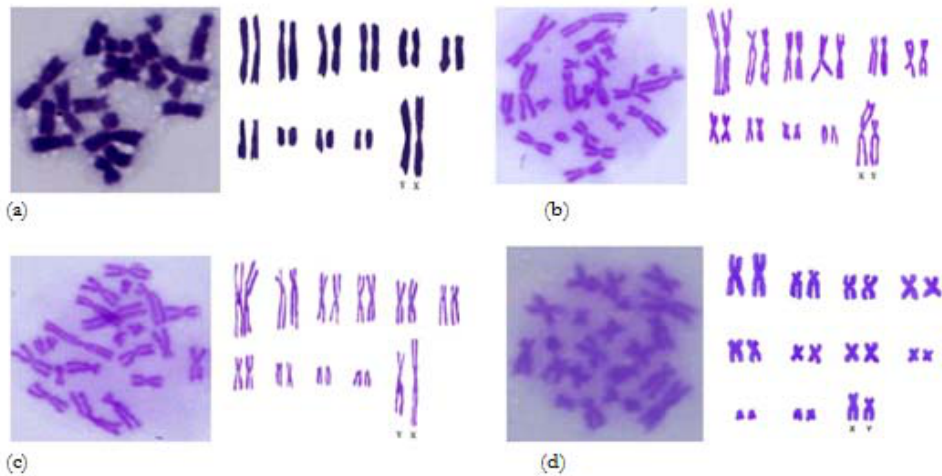
F IGURE 7. Metaphase spreads and idiograms of Cricetulus migratorius (a) Yazd (b) Nayshabour (c) Gonbad (d) Maravtapeh.